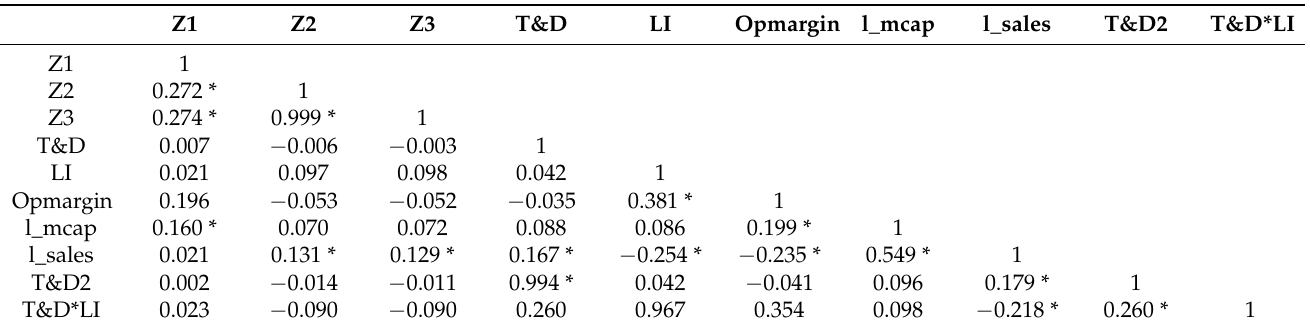
Table 3. Correlation Matrix.